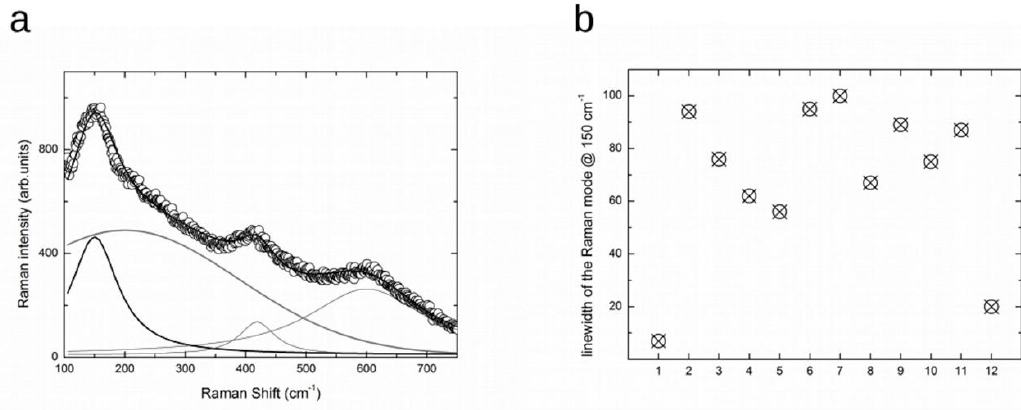
Figure 2. ( a ) Raman spectrum at room temperature for N5 sample (open circle) and the result from the best-fitting procedure (solid line). The single components used to obtain the best-fitting curve are also reported [see text]. ( b ) The values of the linewidth for the Eg mode at around 150 cm-1, derived from the results of the best-fitting analyses from ten Raman spectra (point 2–point 11). The first and the latter are the typical values obtained from a single crystal anatase crystal and nanosized (10 nm) powders.